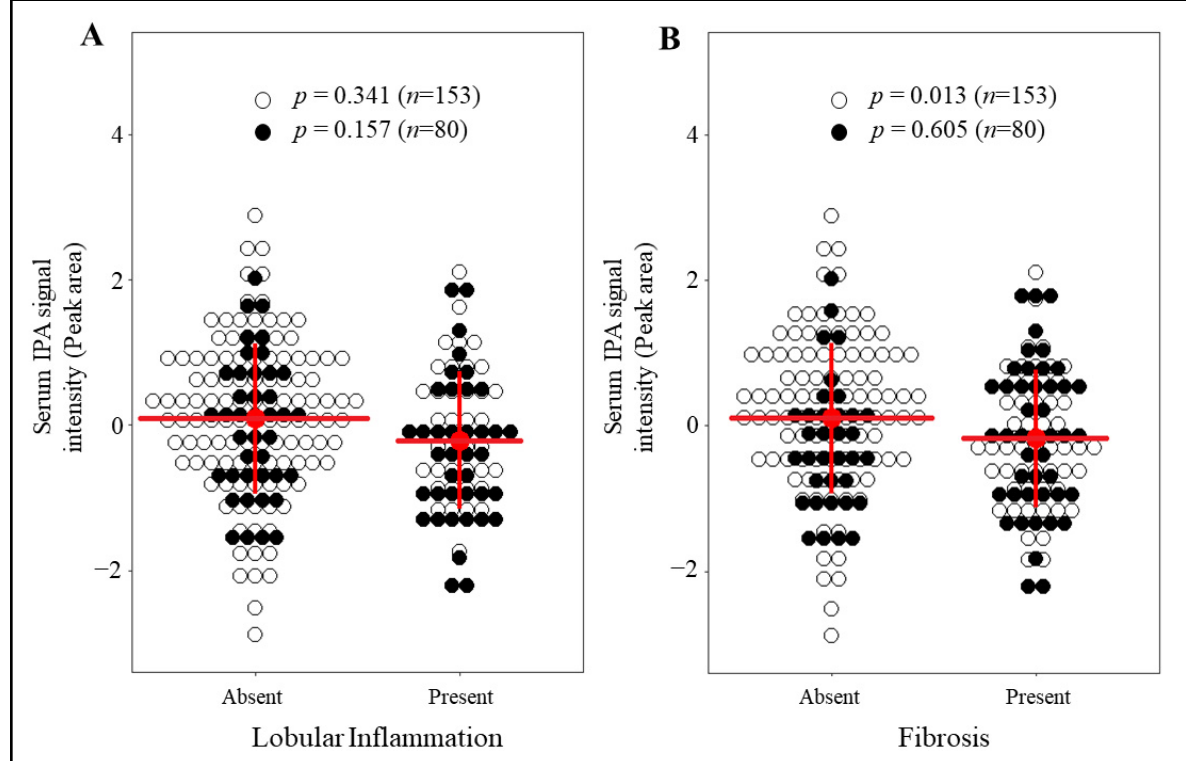
Figure 2. Associations of serum IPA signal intensity with lobular inflammation and fibrosis, based on presence (all except 0) or absence (stage/grade 0) of either lobular inflammation or fibrosis in individuals with or without T2D. Dot plot presents the inverse-normalized serum IPA signal intensities ( y -axis) for ( A ) lobular inflammation and ( B ) fibrosis. The white dots are individuals without T2D, and black are those with T2D. Red lines and whiskers represent mean serum IPA signal intensity and SD respectively for whole population. General linear model (univariate) test results p value is shown as p for each comparison between presence or absence of each specific histological characteristic separately in those with and without T2D.